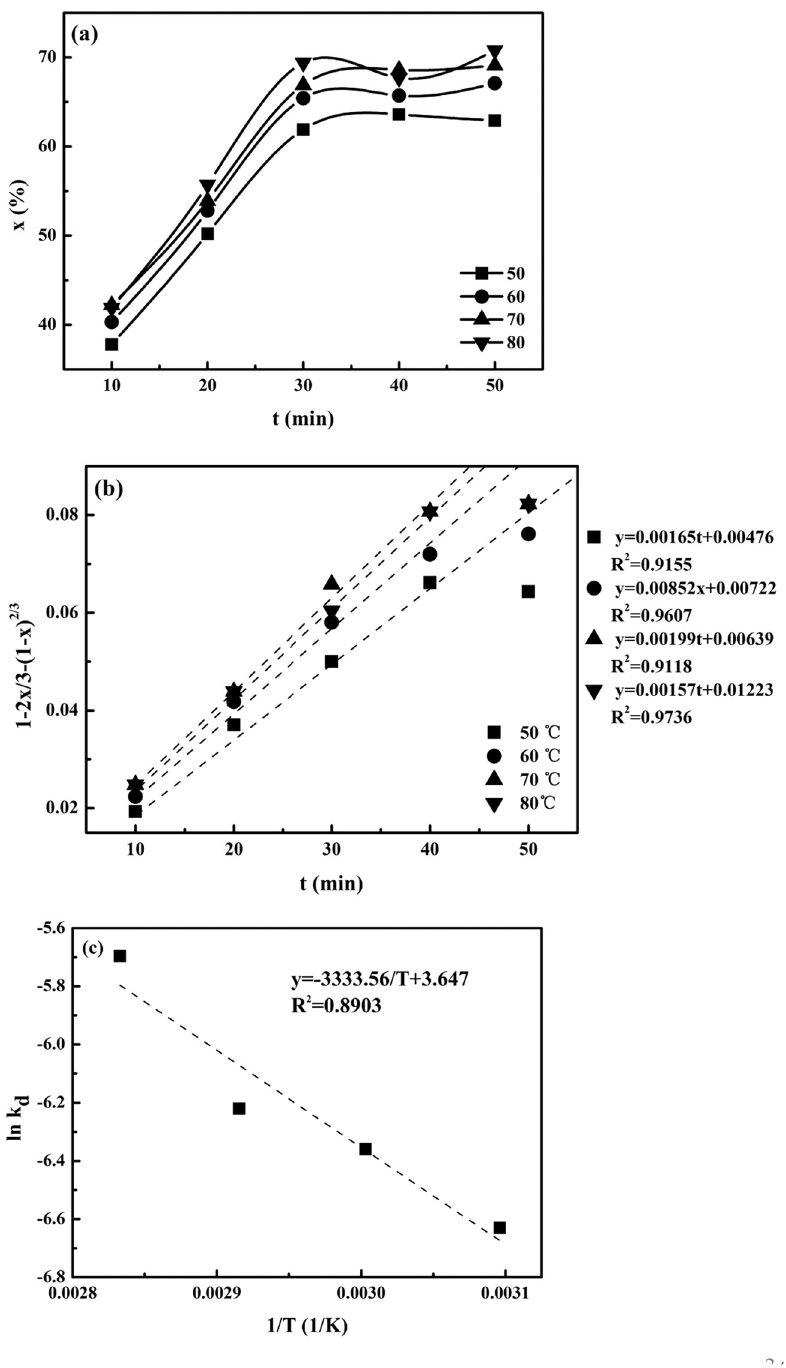
1 and k ln ( acid leaching conditions – H C O 2 3 and ( c ) d 3 T